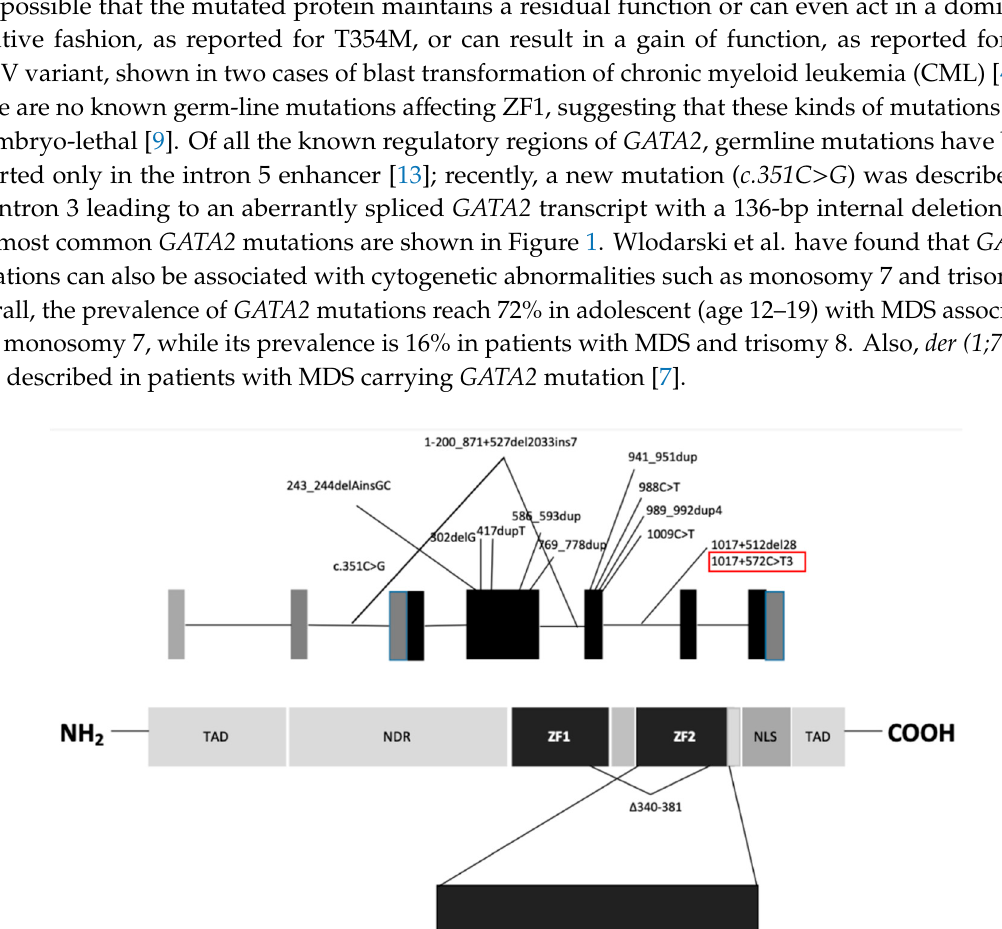
Table 1. Clinical features of GATA2 deficiency.